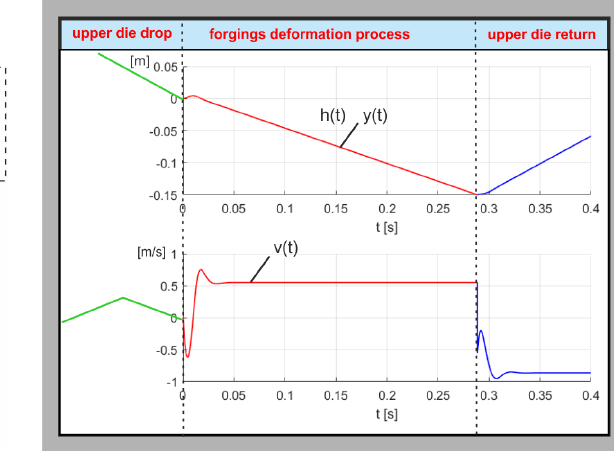
Figure 9: The simulation results of the forging process: plunger